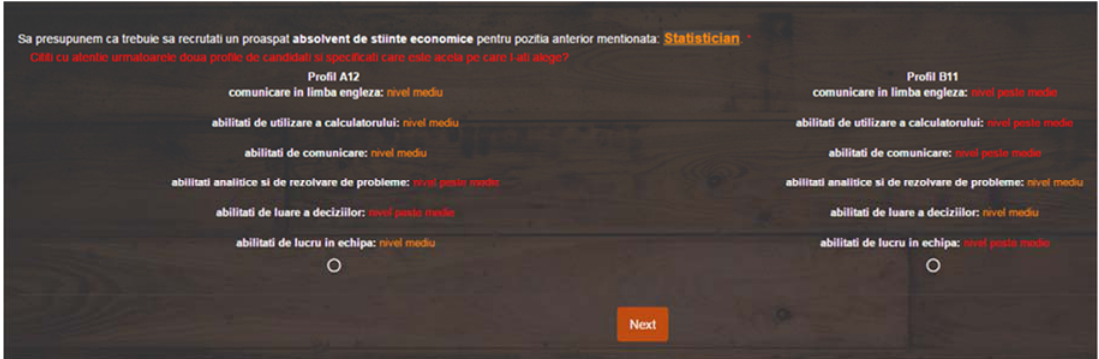
Figure A1. Capture of a conjoint vignette.